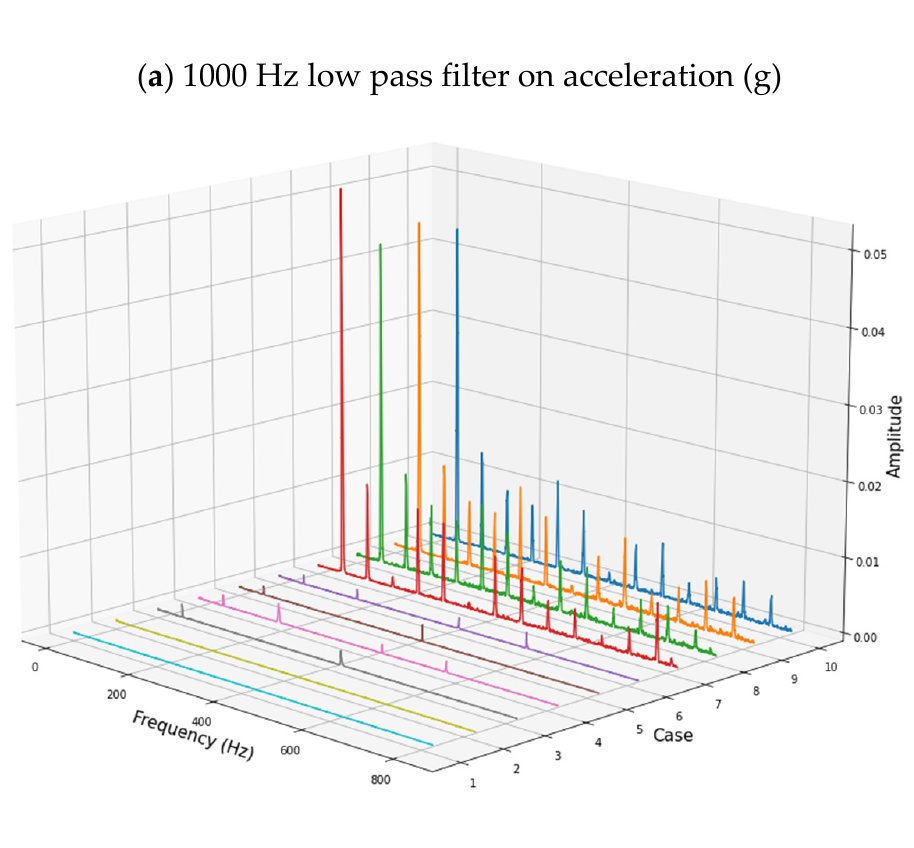
Figure 7. The 1000 Hz low pass filter on acceleration and fast Fourier transform (FFT) results. Case 1 in Figure 7b is the FFT result of the acceleration in the state where there was no leakage and no flow, and case 2 is where there was flow in the pipe but no leakage